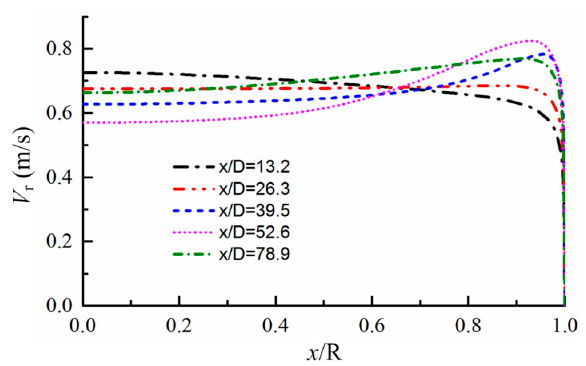
Figure 13. Distribution of the axial velocity ( q/G = 0.0919691).